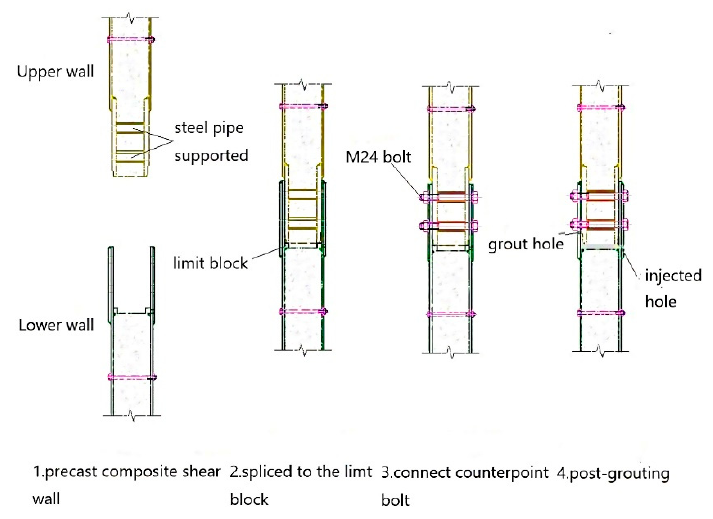
Figure 1. The constitution diagram of composite shear wall.